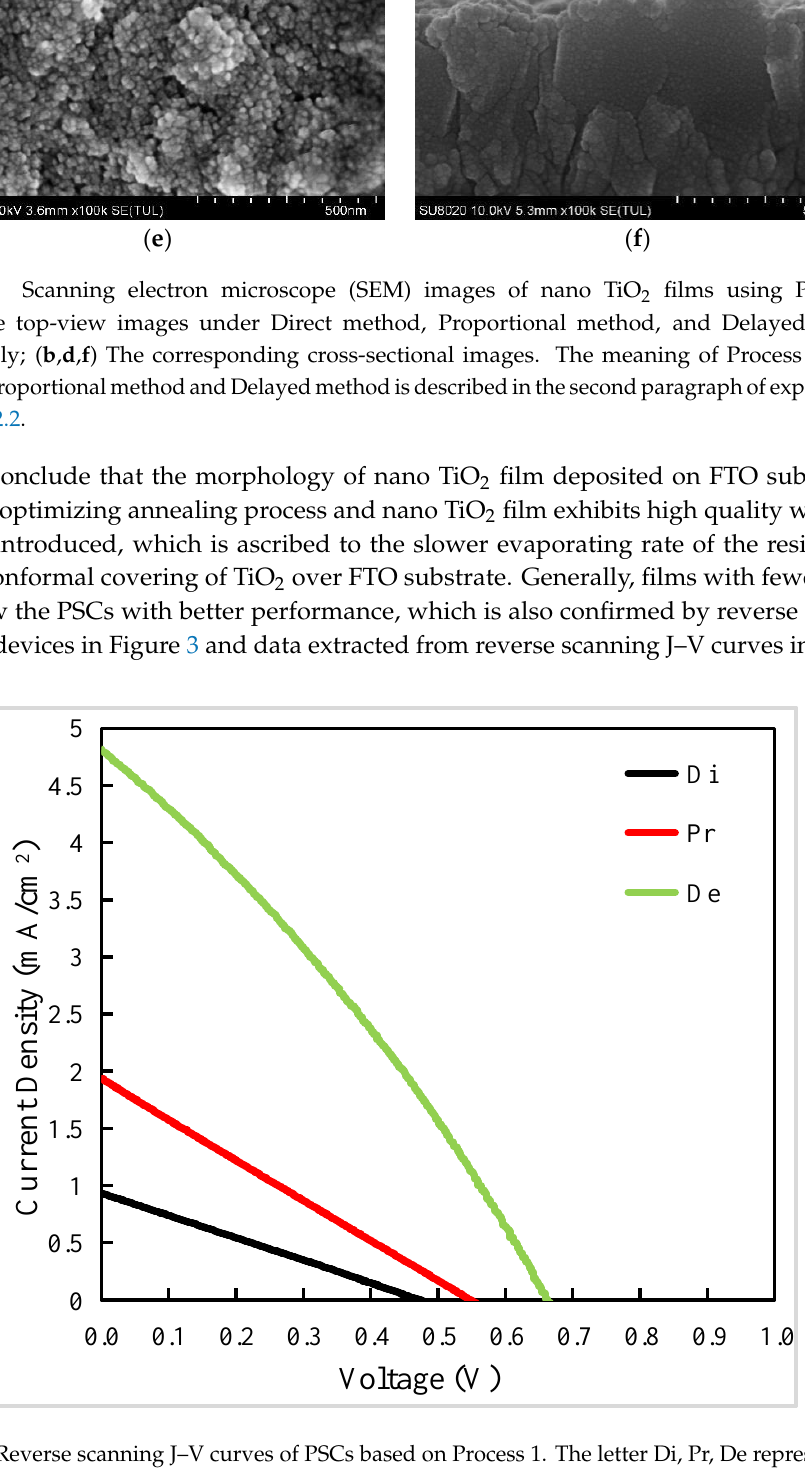
Figure 3. Reverse scanning J–V curves of PSCs based on Process 1. The letter Di, Pr, De represent films prepared with Direct method, Proportional method, and Delayed method, respectively. The device active area is 0.25 cm 2 (0.5 cm × 0.5 cm). The meaning of Process 1, Direct method, Proportional method and Delayed method is described in the second paragraph of experimental Section 2.2.2. Table 1. Data extracted from reverse scanning J–V curves of perovskite solar cells (PSCs) based on Process 1. The letter Di, Pr, De represent films prepared with Direct method, Proportional method, and Delayed method, respectively. The device active area is 0.25 cm 2 (0.5 cm × 0.5 cm). The meaning of Process 1, Direct method, Proportional method and Delayed method is described in the second paragraph of experimental Section 2.2.2. Samples